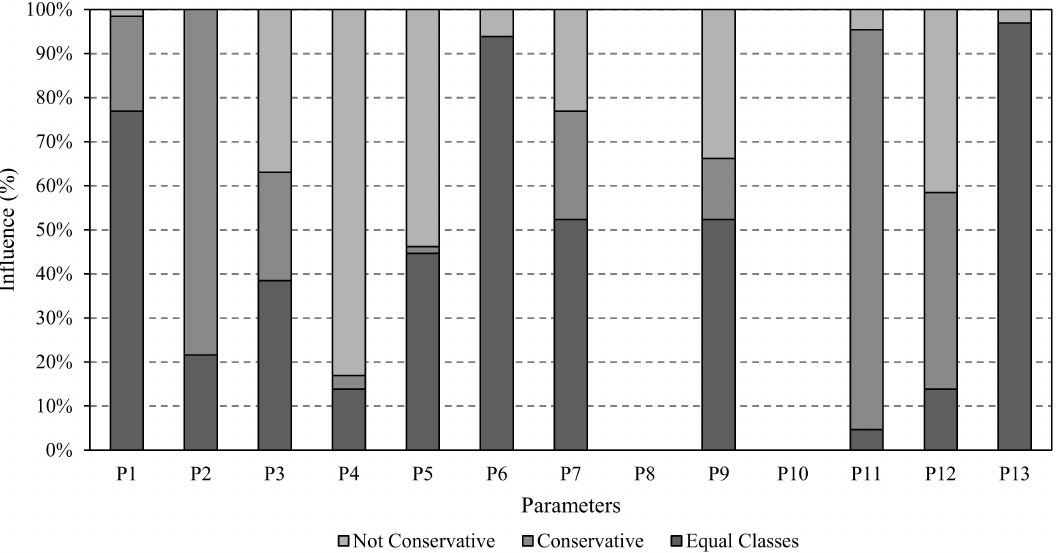
Figure 15. Comparison between the vulnerability classes assigned for each façade-related